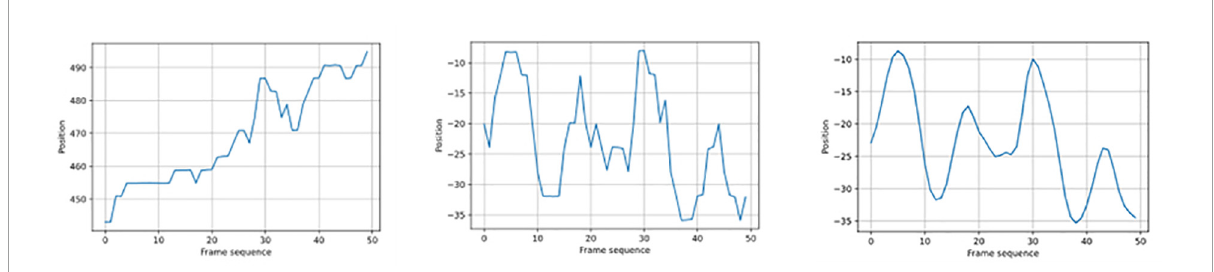
FIGURE5 A comparison of the signal before and after the translation and Gaussian filter.